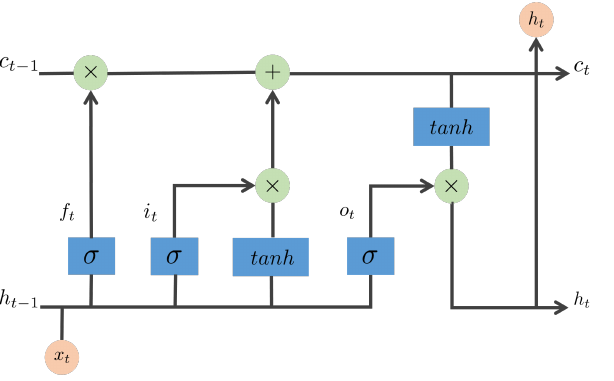
Figure 15. Long Short-Term Memory (LSTM) unit.